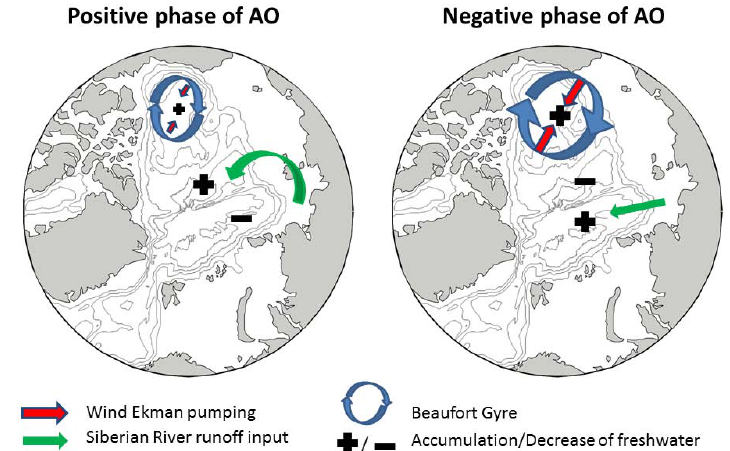
Fig. 11. Scheme of the freshwater circulation during a negative phase of the AO (right) and a positive phase of the AO (left), derived from Steele and Boyd (1998), Johnson and Polyakov (2001), Proshutinsky et al. (2002, 2009), Condron et al. (2008), and Morison et al. (2012). During an anticyclonic regime (negative phase of AO), the Beaufort Gyre anticyclonic circulation is enhanced and Ekman pumping is very strong as a result. Therefore, a large amount of freshwater accumulates at the center of the Beaufort Gyre. In addition, the Siberian River runoff is diverted directly towards the Eurasian Basin. Conversely, during a cyclonic regime (positive phase of the AO), the Beaufort Gyre is weaker than during an anticyclonic regime: Ekman pumping is reduced and less freshwater accumulates. The Siberian River runoff is diverted by eastward winds towards the Makarov Basin rather than towards the Eurasian Basin. As a result, there is an accumulation of freshwater in the Makarov Basin and a deficit of freshwater in the Eurasian